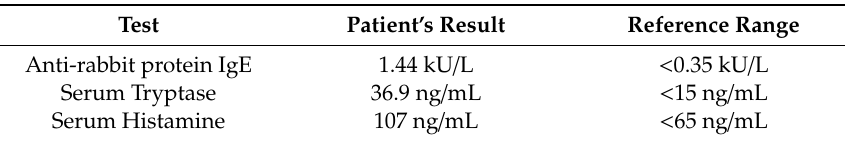
Table 1. Test Table 1. Test Results.